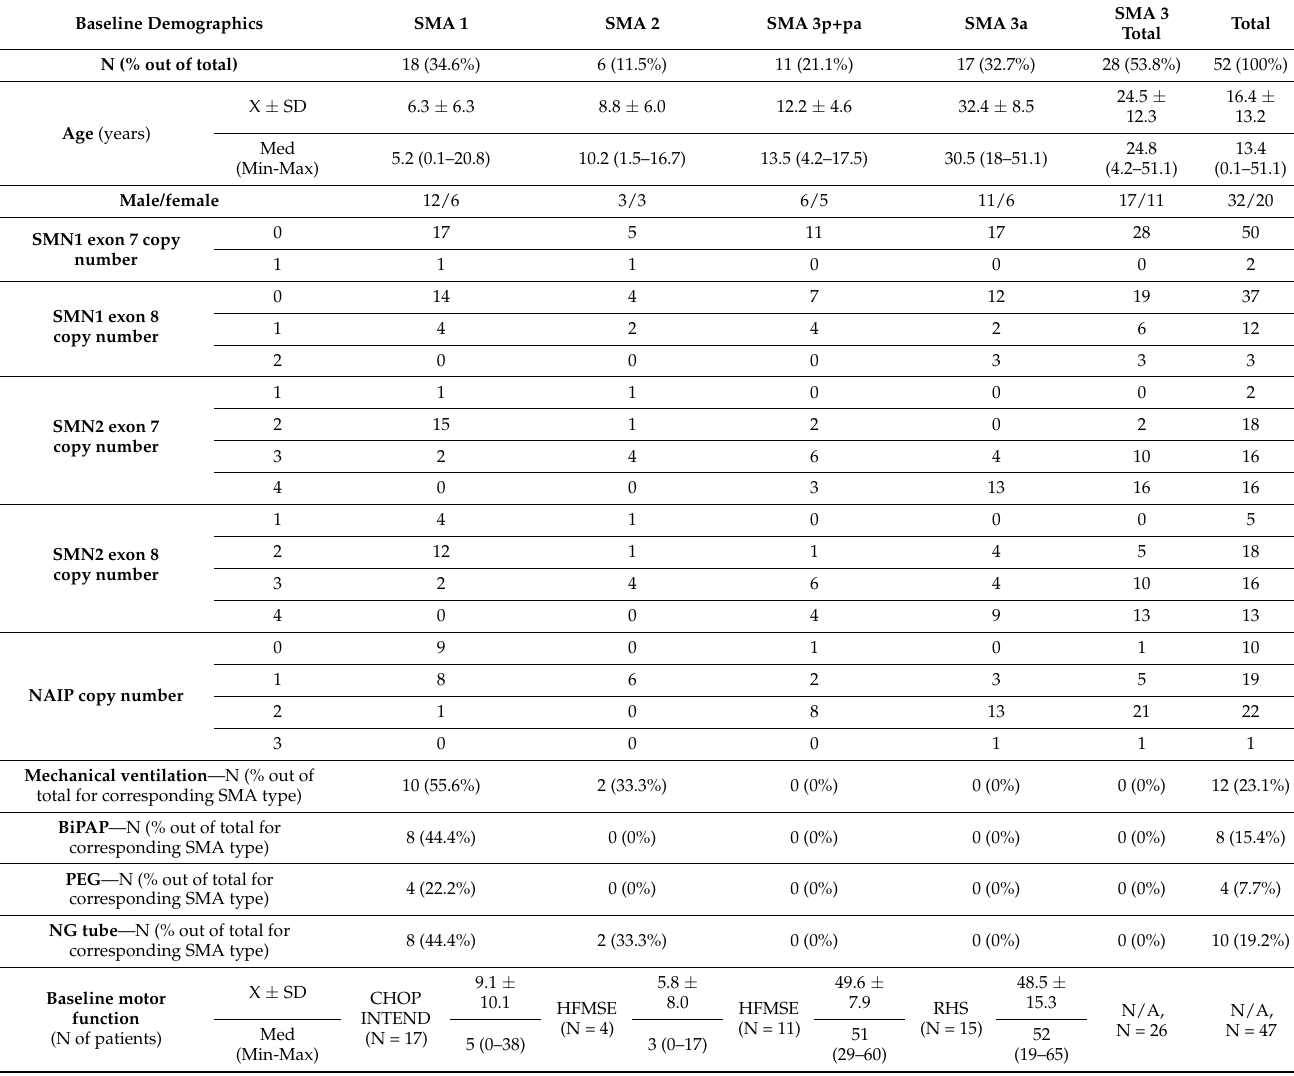
Table 2. Overview of baseline demographic and clinical parameters of all patients, including sub- groups according to SMA